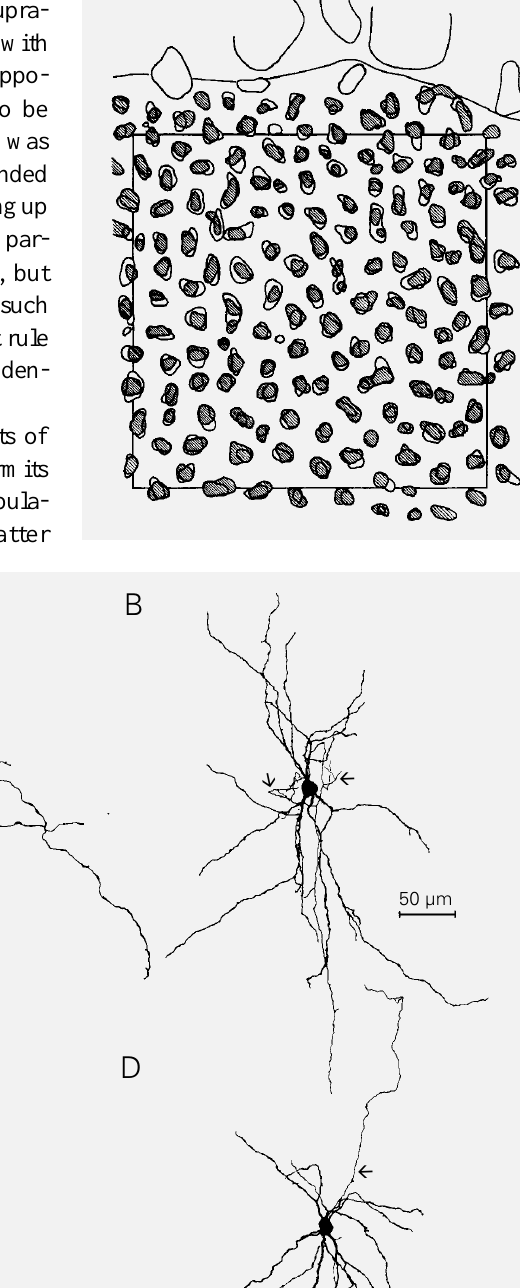
Figure 4 - Camera lucida draw- ing representing the superim- posed blob pattern obtained by using the blood vessels as land- marks. The same sections as il- lustrated in Figure 2B and 2C were used. Blobs revealed by cytochrome oxidase histochem- istry are hatched. Area of the square is 25 mm 2 .